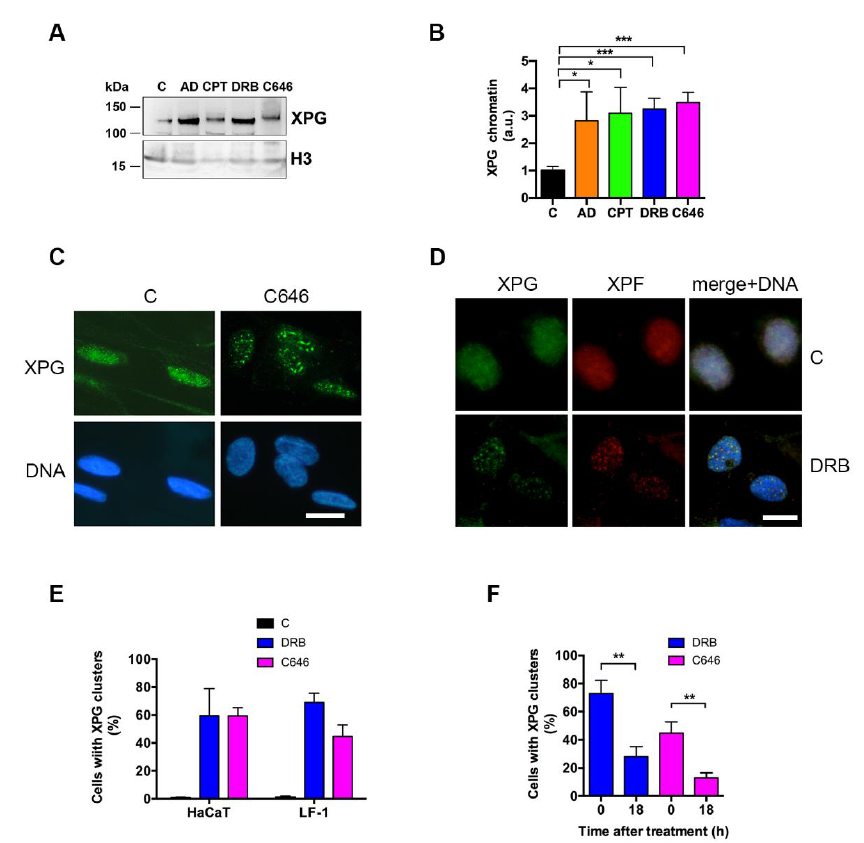
Figure 4. Accumulation and nuclear localization of XPG after transcription inhibition. ( A ) Western blot analysis of chromatin-bound fraction of XPG in LF-1 fibroblasts after treatment with indicated transcription inhibitors, as described in Materials and Methods; histone H3 is shown as a loading control. ( B ) Quantitative densitometric analysis of chromatin- bound fraction of XPG in LF-1 fibroblasts. Mean values ± S.D. of at least three different experiments shown. * p < 0.05; ** p < 0.01; *** p < 0.001. ( C) Immunofluorescence of chromatin-bound XPG in LF-1 fibroblasts in (C) untreated and C646- treated (C646) samples. Scale bar = 10 μm. ( D ) Immunofluorescence analysis of chromatin-bound XPG (green fluorescence) and XPF (red fluorescence) in HeLa cells in untreated (C) and DRB-treated (DRB) samples. Scale bar = 10 μm. ( E ) Quantification of cells showing clustered distribution of XPG in HaCaT and in LF-1 untreated culture samples (C), or after treatment with DRB, or C646. Mean values ± S.D. of three experiments shown. ( F ) Quantification of cells showing clustered distribution of XPG in LF-1 fibroblasts at end of the treatment (0 h), and after 18 h recovery in the absence of the inhibitor. Mean values ± S.D. of three experiments shown. (** p <